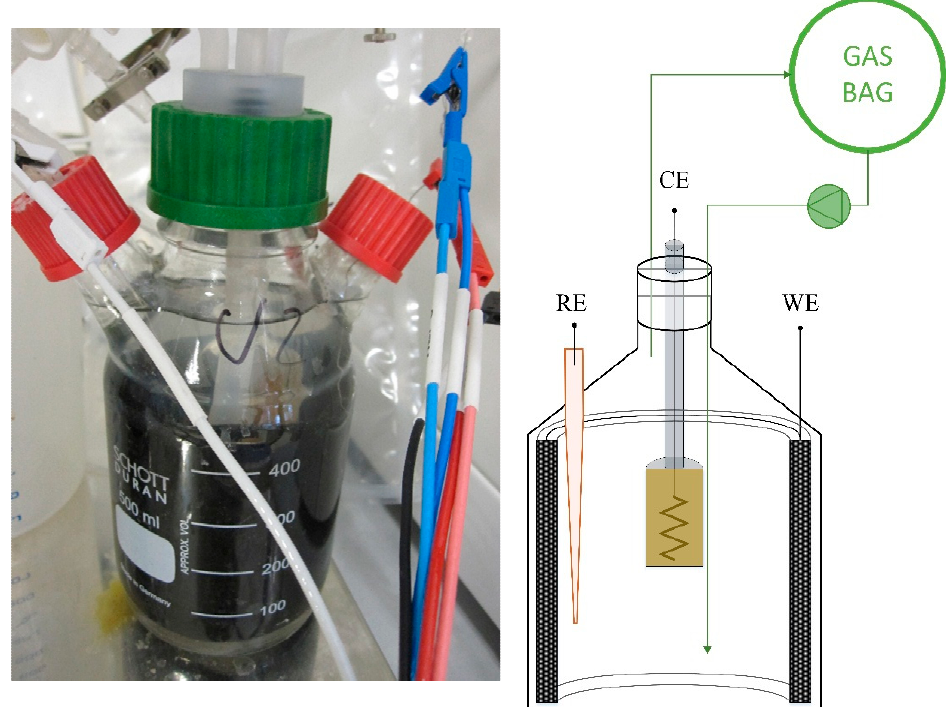
Figure 1. Image and diagram of reactor setup. CE: counter electrode; RE: reference electrode; WE: working electrode.